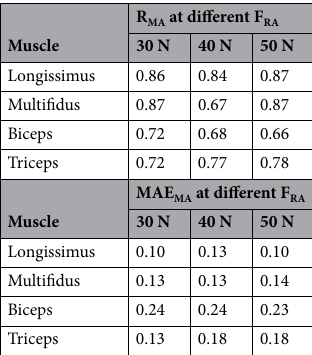
Table 6. The average R and MAE of the muscle activations for the longissimus, multifidus, biceps and triceps between OpenSim and EMG (R MA , MAE MA ) at different F RA